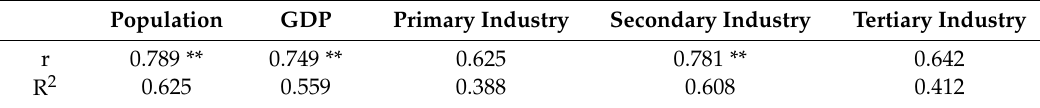
Basin; ( e ) Correlation tertiary industry and degree of combined pollution of eutrophication in water bodies and potential risk of heavy metals in sediments in the Haihe River Basin. Table 6. Pearson correlation coefficients (r) and R 2 between combined pollution of water environmental and socio-economical factors in the Haihe River Basin. Population GDP Primary